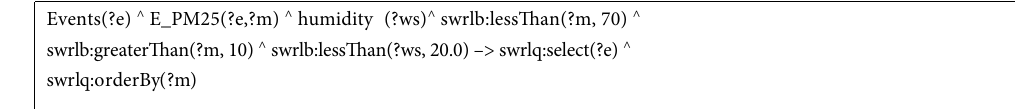
Figure 13: SWRL to count “ 𝑎 ”.